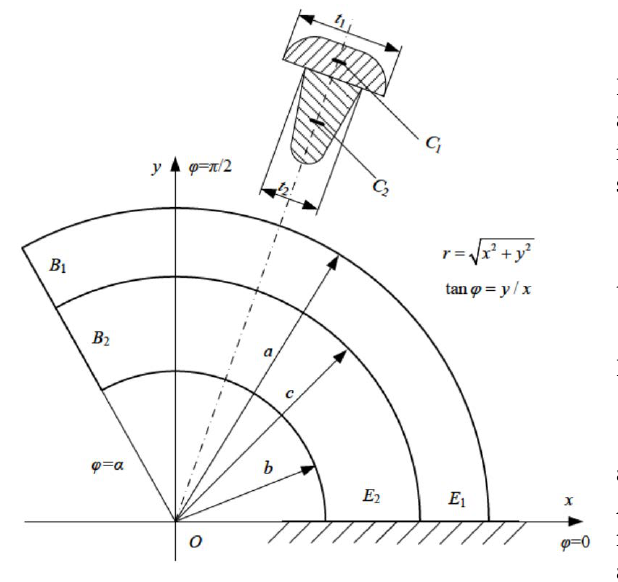
Figure 2: Two-layer curved